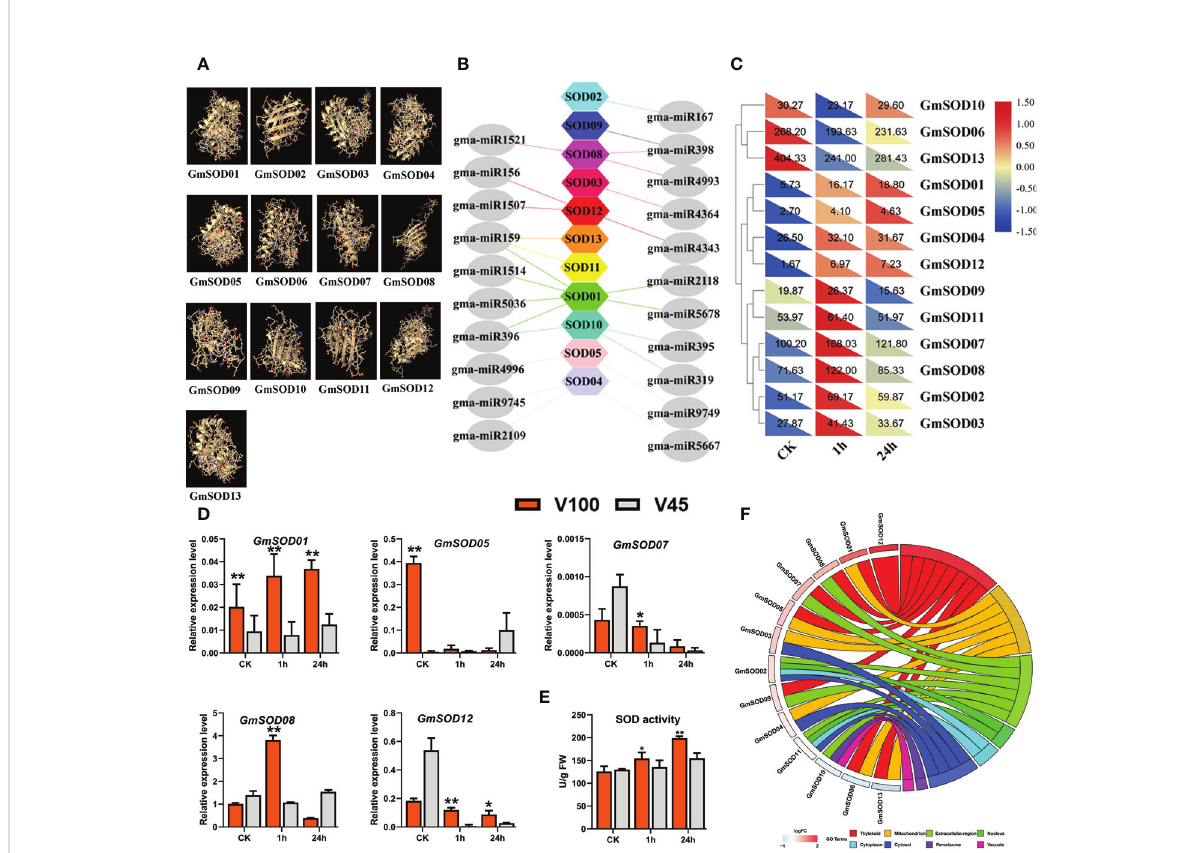
FIGURE 6 GmSOD genes and posttranscriptional regulation in V100 and V45. (A) Predicted protein structure of GmSOD genes in Soybean. (B) Post- transcriptional regulation of GmSOD genes by gma-miRNA. (C) RNA-seq expression analysis of GmSOD genes under (CK) and cold stress conditions. Expression data was normalized by log 2 FC. (D) qRT-PCR veri fi cation of GmSOD genes in V100 and V45. (E) SOD enzyme activity. (F) Gene ontology analysis of GmSODs. Data was analyzed with the Statistix 8.1. The ** and * asterisks indicate the signi fi cant differences at p- value <0.01 and p-value <0.05,